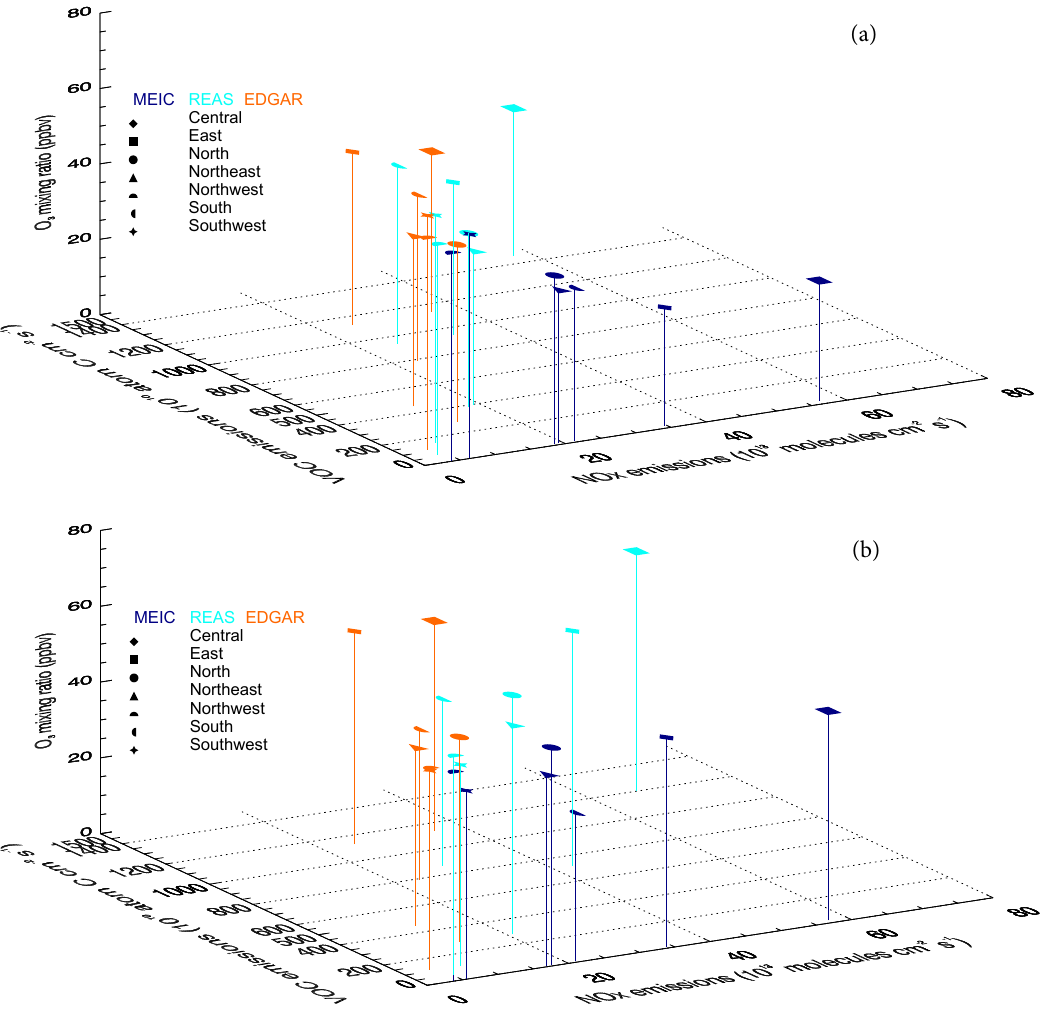
Figure 16. (a) Emissions of NO x and VOCs as well as O 3 mixing ratio in each region in January using three emissions inventories. (b) Emis- sions of NO x and VOCs as well as O 3 mixing ratio in each region in July using three emissions